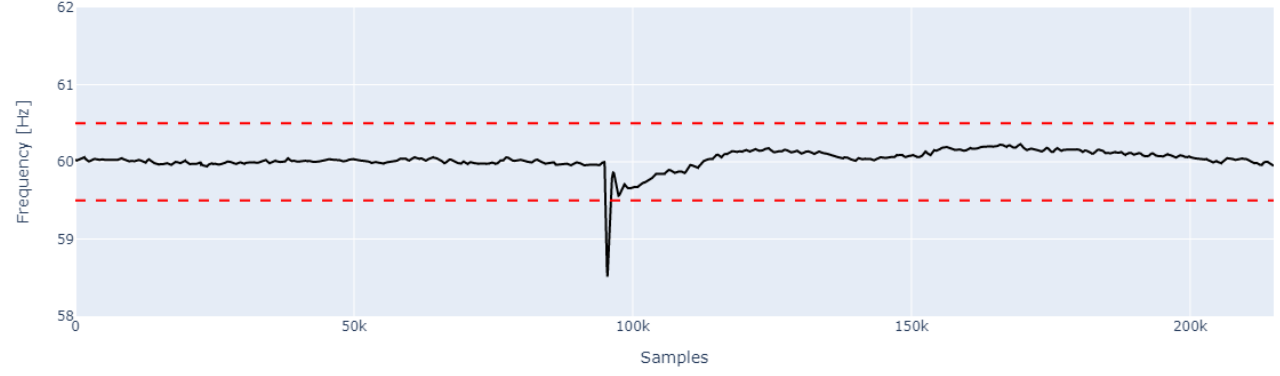
Figure 5. Event 1: frequency of PMU Apucarana (in the north of Parana State).